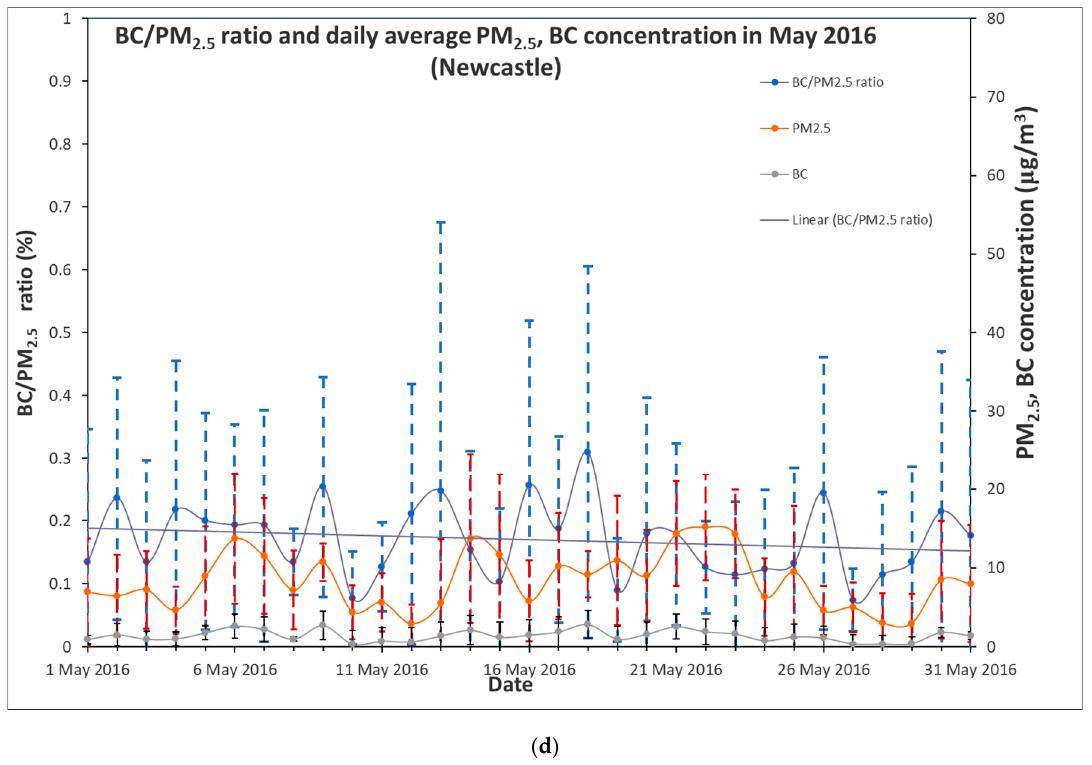
Figure 12. Regression of BC versus PM 2.5 for May 2016: ( a ) at Chullora; and ( b ) at Newcastle. Chullora is more affected by HRBs as shown by the two distinct regression patterns (below 20 μ g/m 3 and above 20 μ g/m 3 ). Daily average ratio of BC/PM 2.5 (with trend line), PM 2.5 and BC concentration during May 2016: ( c ) at Chullora; and ( d ) at Newcastle. The dotted vertical lines are the ± σ (standard deviation of intraday hourly variation on the day) from the daily mean.